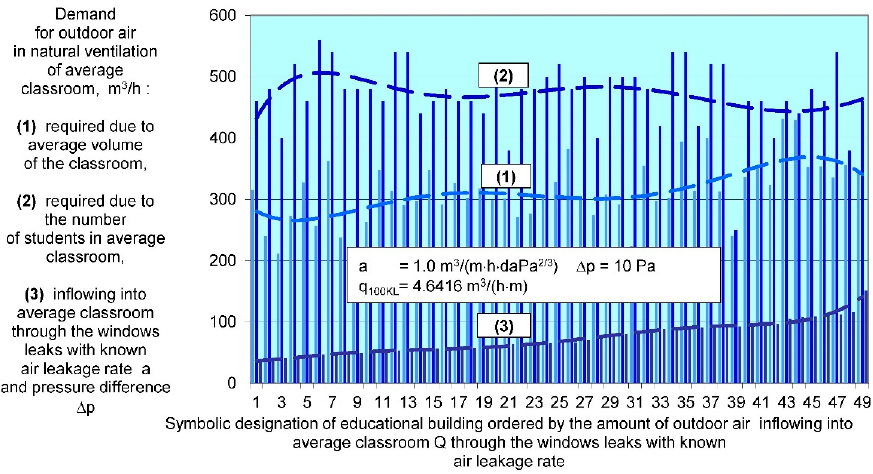
Figure 12. The quantity of air flowing into the classroom from the outside through new windows that meet the technical requirements- a = 1.0 m 3 /(m h daPa 2/3 ), corresponding to q 100KL = 4.6416 m 3 /(h ⋅ m). They depict three columns in different shades of blue drawn up for individual build-